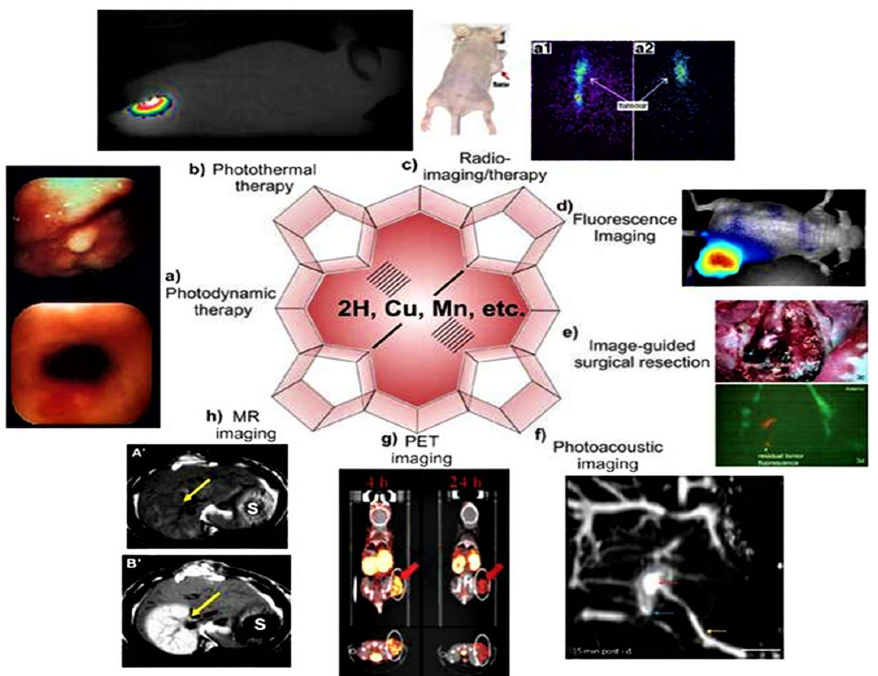
Figure 2. Diagram showing the multi-applications of porphyrins ( a, b, e ) including different imaging capabilities ( c, d, f, g and h ) of porphyrins [12].